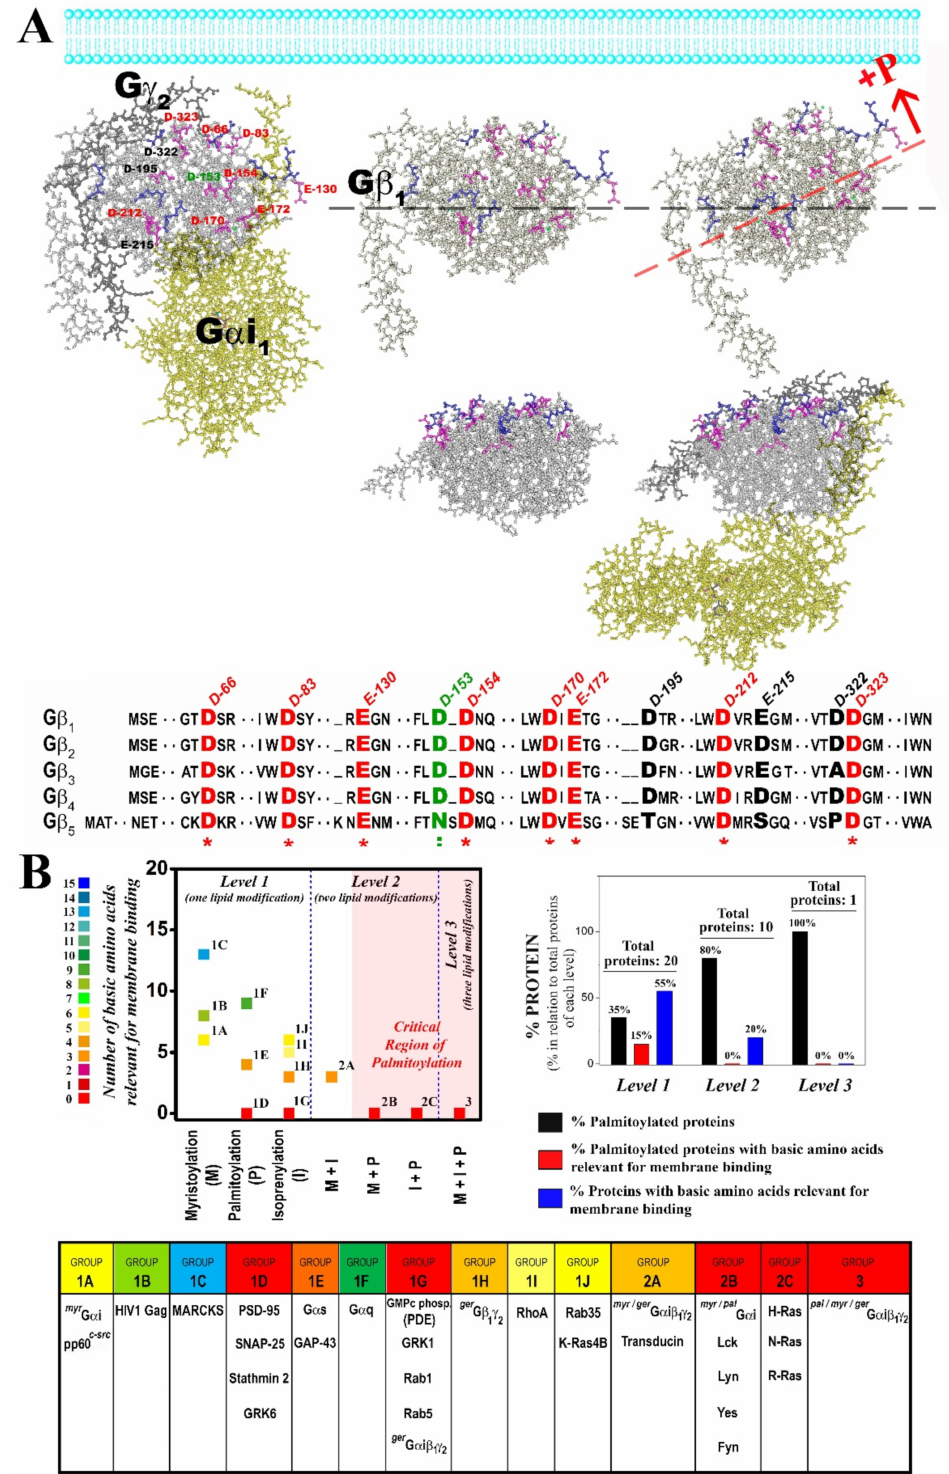
Figure 10. Lipid modifications to G proteins and other peripheral membrane proteins affect their interaction with anionic membrane lipids. ( A ), Possible orientation of G α i1 β 1 γ 2 with respect to the surface of the plasma membrane. The incorporation of a palmitoyl moiety (+P) to G α i1 would induce a conformational switch in the relative position of the G α i1 β 1 γ 2 complex with respect to the lipid bilayer plane. G β 1 would be tilted to the membrane side where the palmitic acid is bound to G α